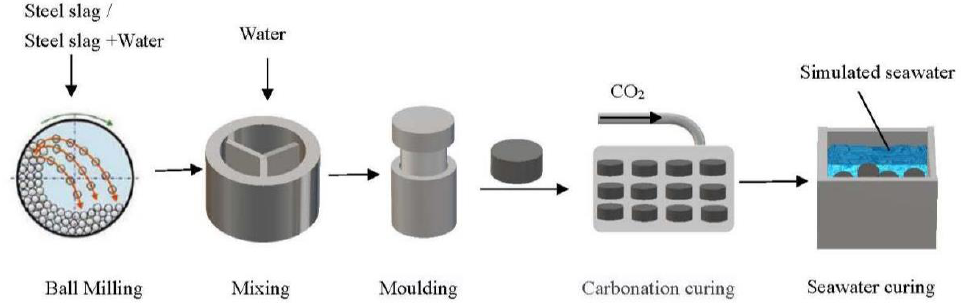
Figure 2. The flow chart of the experiments.